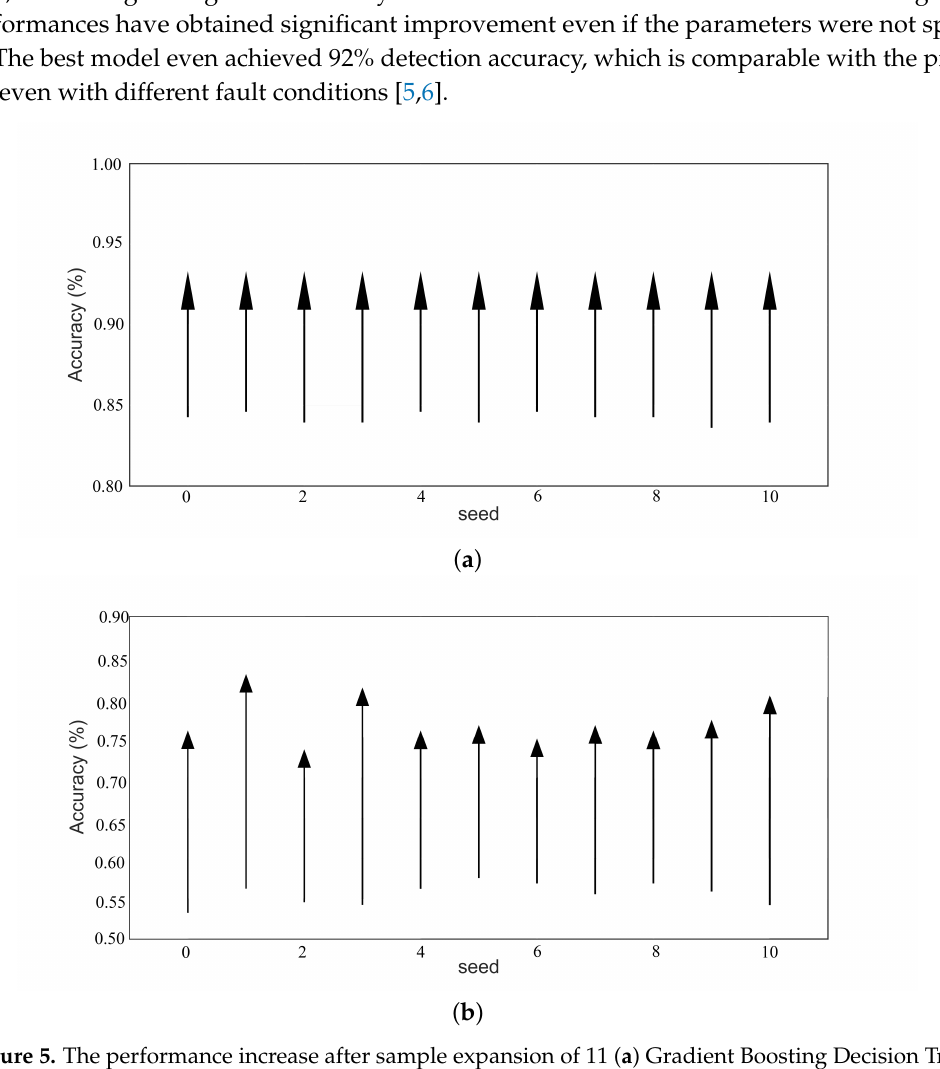
Figure 5. The performance increase after sample expansion of 11 ( a ) Gradient Boosting Decision Tree and ( b ) Multi-Layer Perceptron